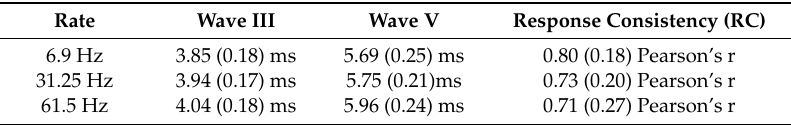
Table 3. Descriptive statistics of auditory brainstem response (ABR) absolute latencies and Response Consistency (RC). Means and standard deviations (parenthesis) or ABR absolute latencies and the RC measures. Here, the response consistency (RC) reflects the repeatability of the click ABR over the duration of the recording session (i.e., a higher RC means a more consistent ABR).